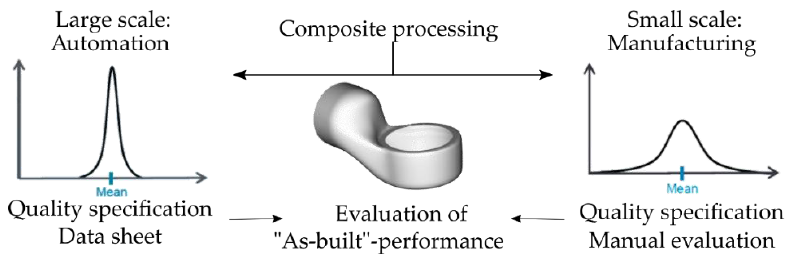
Figure 1 . Quality distribution of composite parts in the production method. Figure 1. Quality distribution of composite parts in the production method.